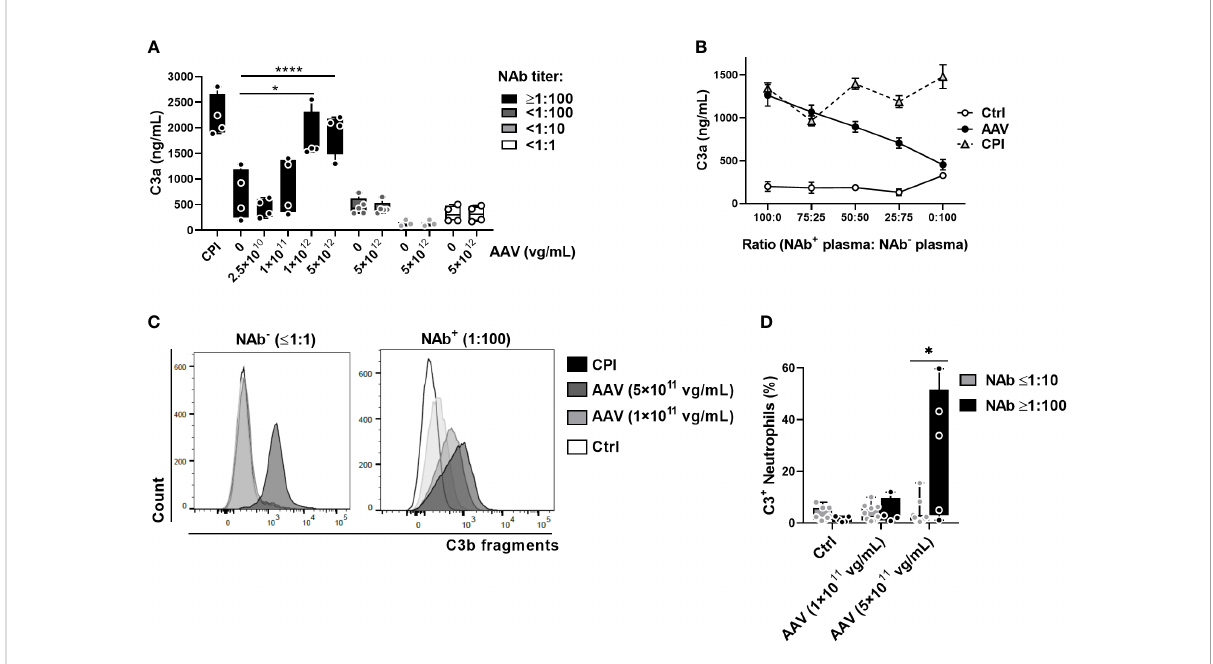
FIGURE 5 AAV NAbs enhance AAV-induced complement activation and C3 split products deposition on neutrophils. (A) C3a levels in human plasma with the indicated NAb titers, treated for 1 hour with various concentrations of AAV-Spark100. Signi fi cance was determined with a two-way ANOVA with Sidak ’ s multiple comparisons test, *p ≤ 0.05, ****p ≤ 0.0001. (B) NAb - (<1:1) and NAb + ( ≥ 1:100) plasma was mixed at the indicated ratios and stimulated with 5×10 11 vg/mL of AAV-Spark100. Mean C3a levels ± SEM are shown (n=8). (C) Representative FACS plots and (D) graph of C3 fragment deposition on CD11b + cells in the blood at 90 minutes after treatment with the indicated concentrations of AAV-Spark100. Bars represent the mean ± SEM and symbols represent the values of individual donors. Signi fi cance determined using the Holm-Sidak method *p ≤